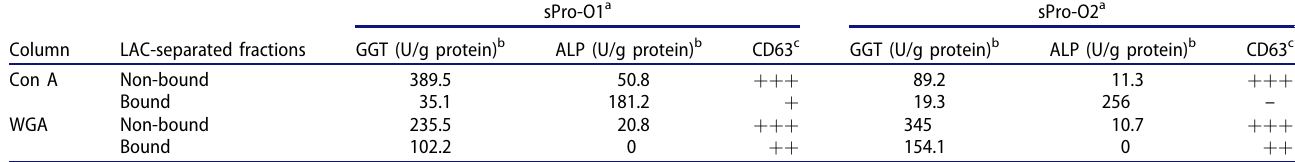
a sPro-O1 and sPro-O2: different isolates of seminal prostasomes from oligozoospermic men. b Enzyme activity (U/L) was normalised to concentration of proteins (g/L) in corresponding fraction. c CD63: immunoreactivity as determined by dot-blot ( þþþ intense; ± low/hardly visible). ALP: alkaline phosphatase; GGT: gamma-glutamyl